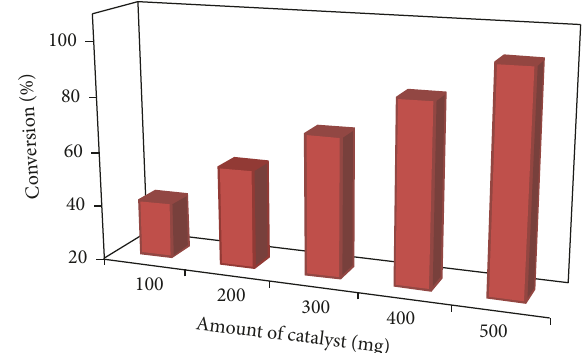
Figure 10: Catalytic activity of 1% ZnO function of catalyst